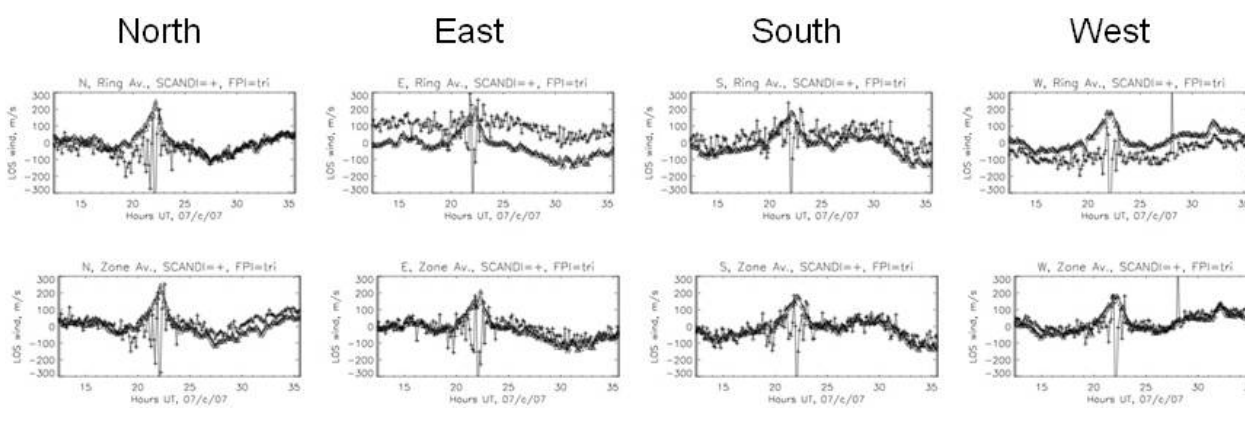
Fig. 8. Comparison of SCANDI LOS winds with FPI LOS winds using two methods of determining the zero-Doppler shift baseline. In the top row the baseline for each zone is determined from the average offset for each zone, i.e. each data point (triangle) in Fig. 7. There is good agreement between the SCANDI and FPI LOS winds. In the bottom row the baseline for all zones in a given ring is determined from the average offset for that ring, i.e. the dashed lines in Fig. 7. There is a large systematic offset between the SCANDI and FPI LOS